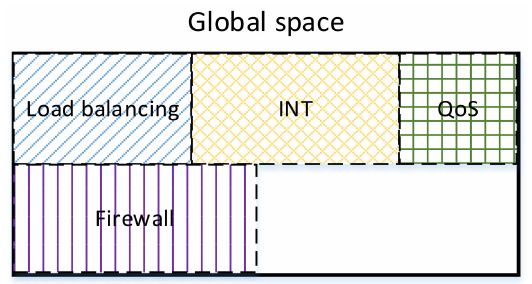
Figure 7. The global space is used to record application-defined types of data.